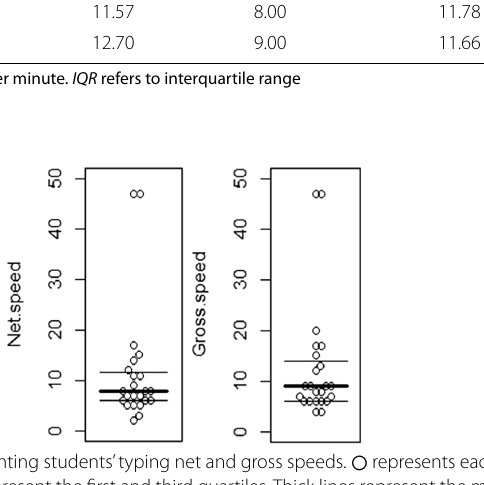
Table 3 Descriptive statistics of students’ typing net and gross speeds n M Median SD IQR Net. speed Gross. speed The unit of measurement is words per minute. IQR refers to interquartile range